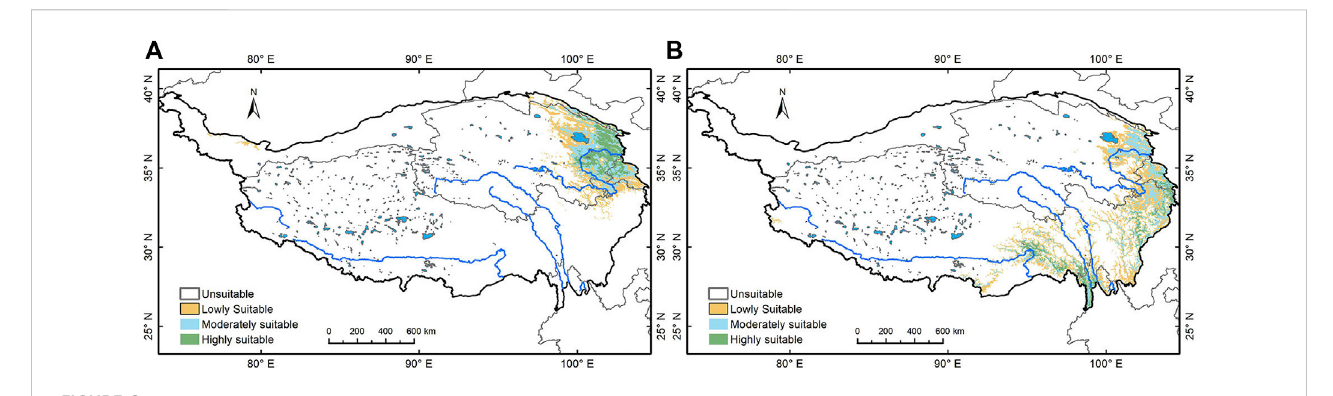
Simulation of Picea and Pinus ’ current geographical distribution. (A) Picea and (B)